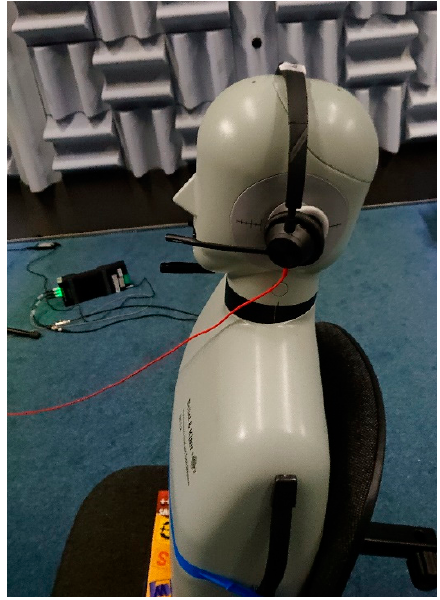
Figure 1. Measurement system for the noise parameters generated by headsets. On the left, the Brüel&Kjær PULSE 3052-A-030 030 (Hottinger Brüel&Kjær A/S, Virum, Denmark) measurement module is shown in the background; the acoustic manikin Brüel&Kjær High-frequency Head and Torso Simulator Type 5128 (Hottinger Brüel&Kjær A/S, Virum, Denmark) with attached headset is shown in the foreground.